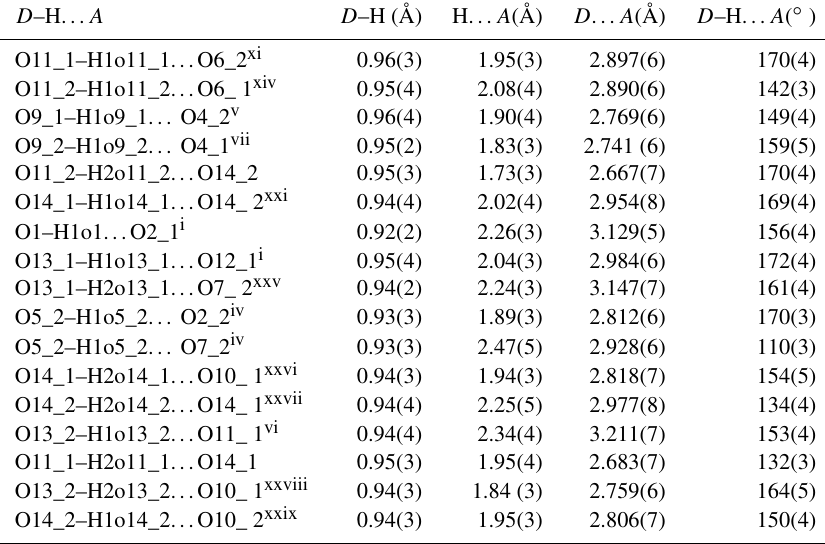
Table 8. Hydrogen-bond geometry (Å, ◦ ) in the crystal of beraunite.